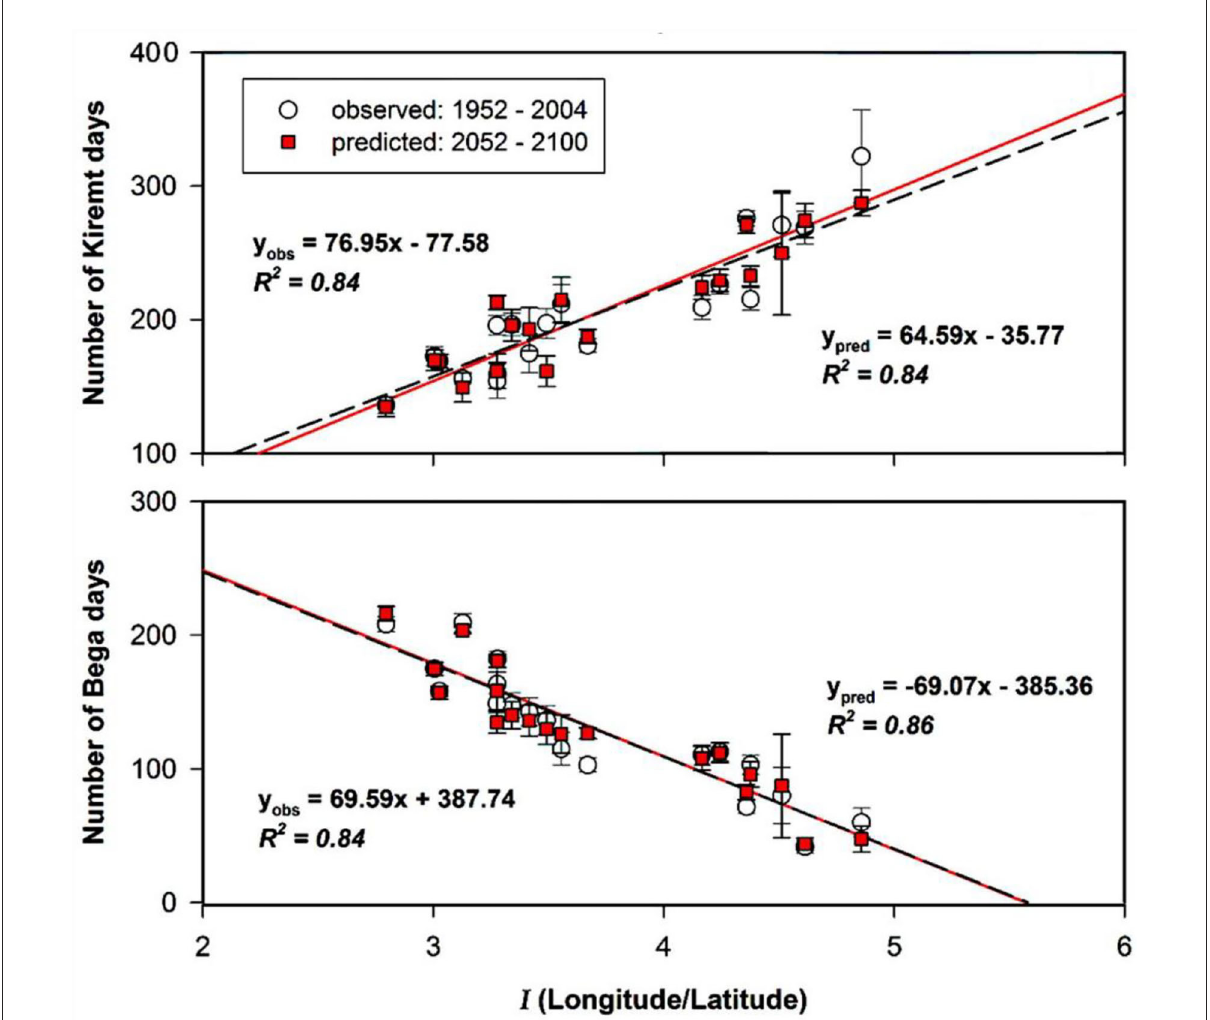
FIGURE8 Presence of Kiremt and duration of Kiremt (the main wet season) and Bega (the dry season) correlated to the index of coordinates, I. The correlation represents observed data (1952–2004) in circles and predicted data a century later (2052–2100) in squares over the upper Blue Nile Basin. Source (Mellander et al.,